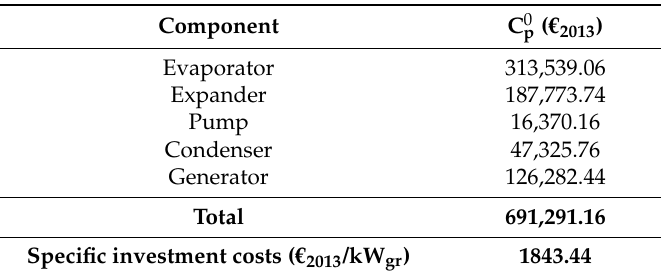
Table 4. Factorial estimation of the purchased equipment